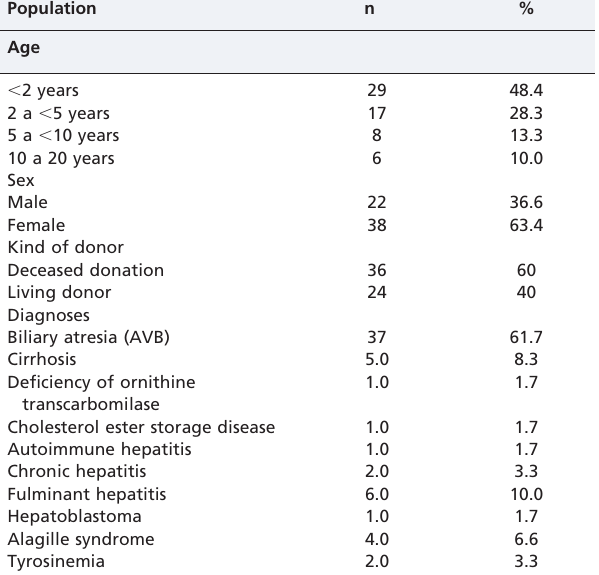
Table 1 - Main characteristics for study subjects.